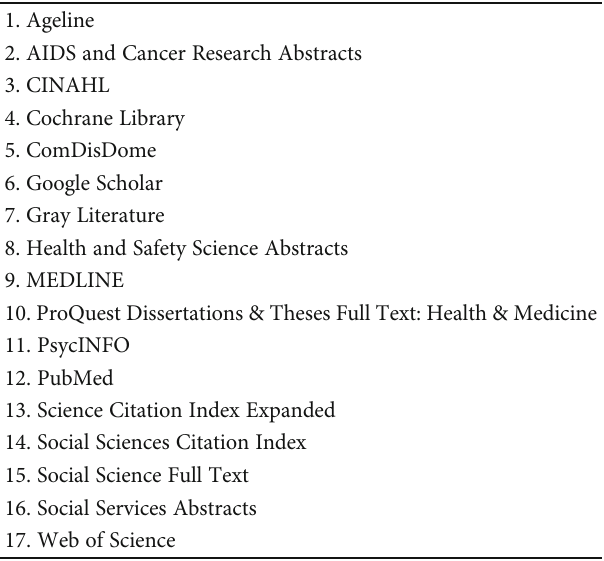
Table 1: Academic databases